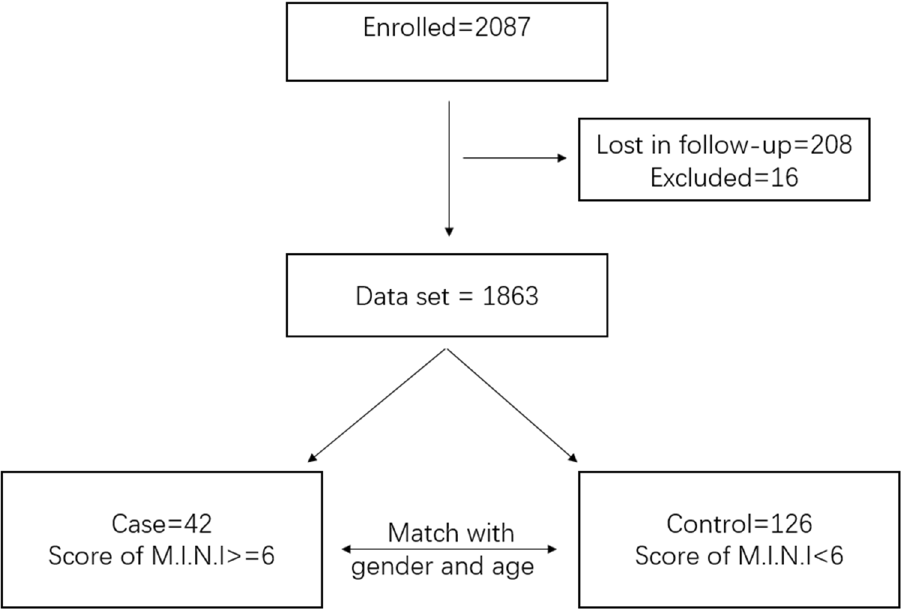
Figure 1. The flowchart of the study